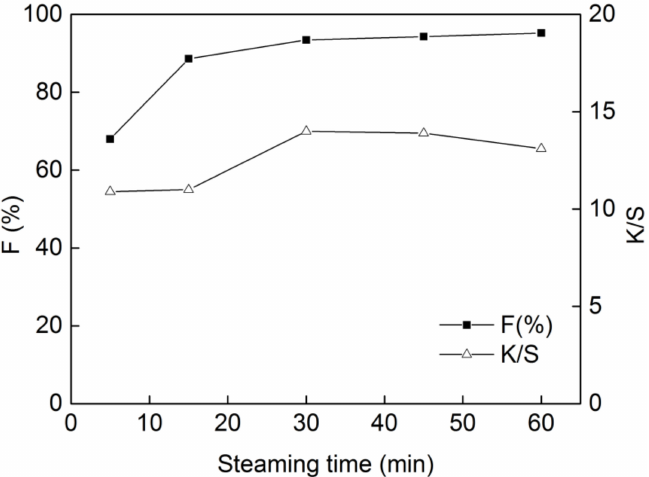
Figure 7. Effect of steaming time on dyeing properties of DB 1 (dye concentration of 25 g/L, sodium carbonate of 12 g/L and dipping time of 3 min with “one-dip–one-nip” process).